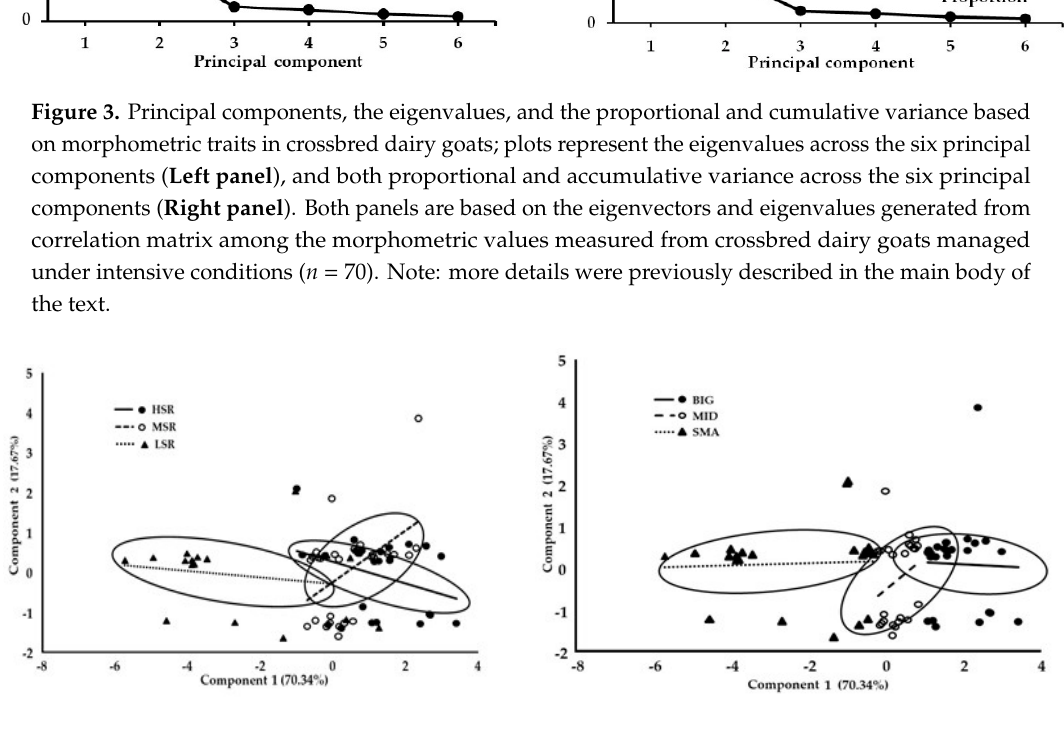
Figure 4. Principal component analysis performed on the morphometric variables in goats; plots represent the first two principle components, considering the scores of the morphological characters representing the morphospace, according to social ranks (i.e., high, HSR; medium, MSR; low, LSR) ( Left panel ) as well as according to body size (i.e., big, BIG; medium, MID; small, SMA) ( Right panel ). Both panels are based on the eigenvectors and eigenvalues generated from the correlation matrix among the morphometric values measured from crossbred dairy goats managed under intensive conditions ( n = 70). Note: More details were previously described in the main body of the text.